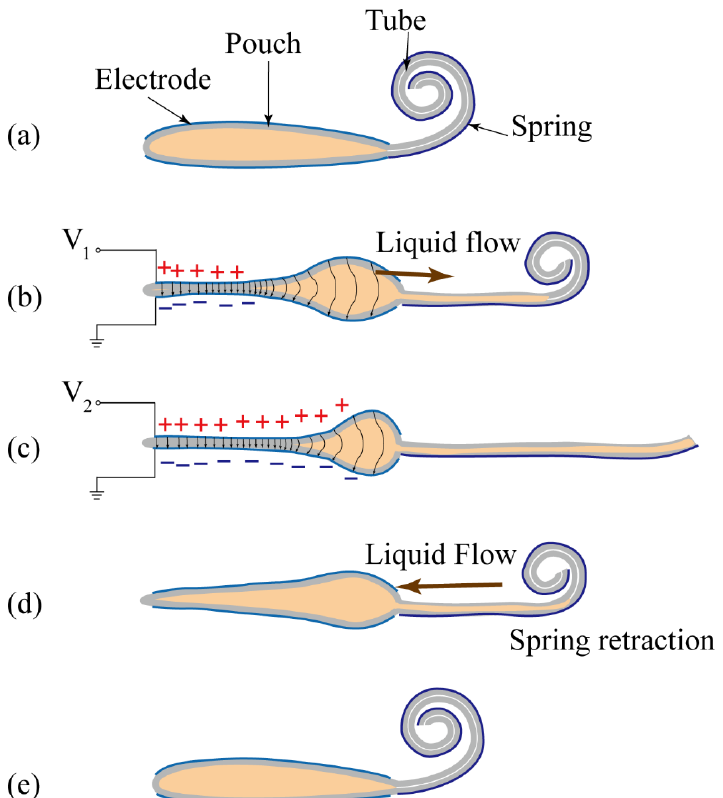
Figure 2. The coiling and uncoiling motions of the proboscis actuator. ( a ) The original shape of the actuator under no external voltages. ( b ) When applying external voltage, V 1 , the DFT forces liquid flow into the empty tube to uncoil the tube. ( c ) As the voltage increases, the soft tube flattens with a flexible and stiff shape. ( d ) When removing the external voltages, the tube coils due to the elastic spring. ( e ) The actuator returns to its original shape.